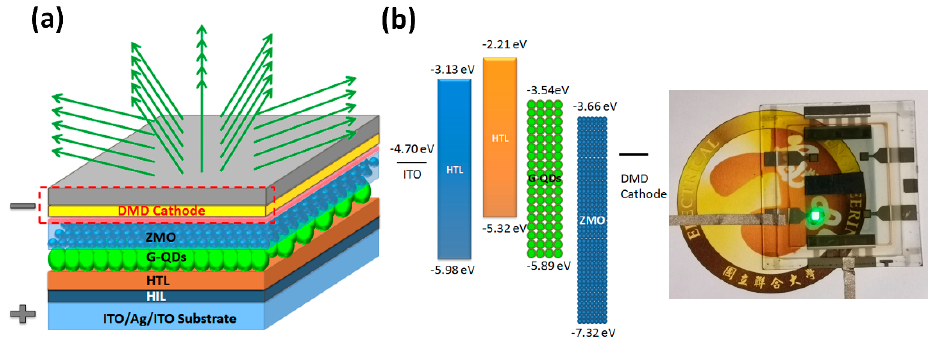
Figure 4. ( a ) Schematic of the device structure. ( b ) Energy band diagram of the red top-emission QLEDs. Photograph of the working QLEDs. Photograph of the working device.